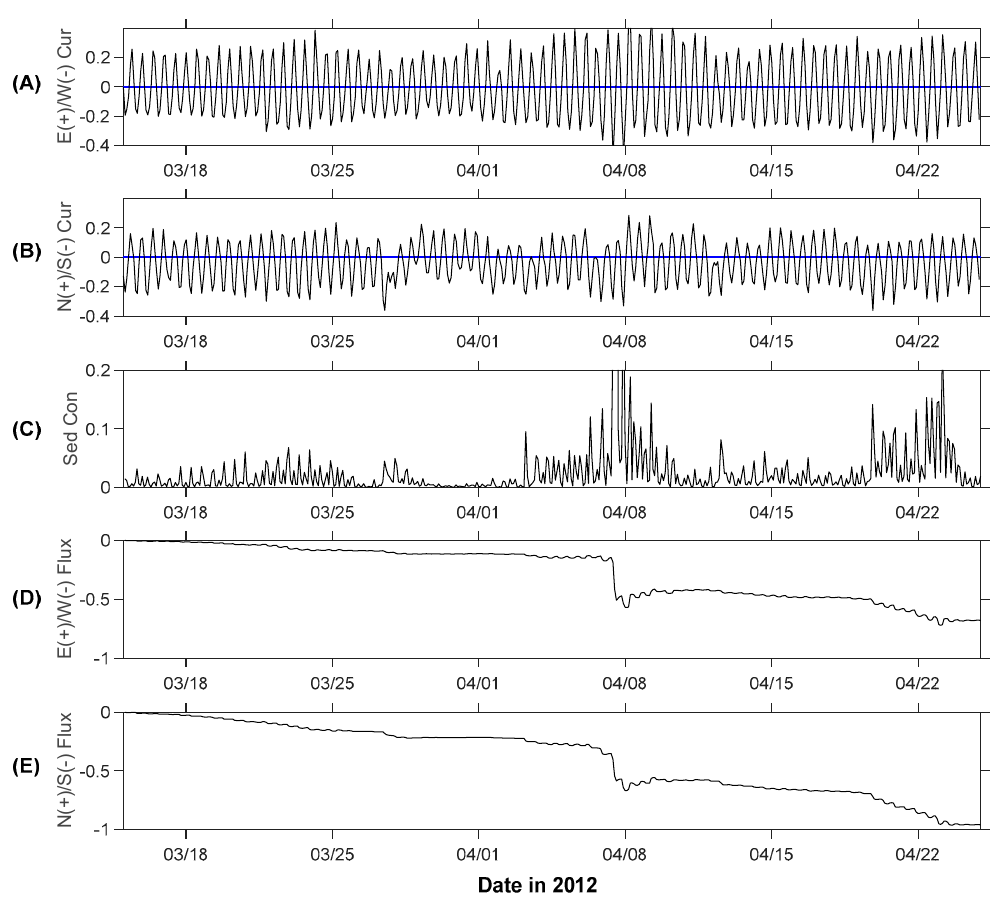
Figure 8. ( A ) East( + ) / west( − ) and ( B ) north( + ) / south( − ) currents in m s − 1 from PCADP data at 0.7 m above bed collected at R1 in spring 2012. ( C ) Sediment concentration in kg m − 3 from ABS data at 0.7 m above bed collected at R1 in spring 2012. ( D ) East( + ) / west( − ) and ( E ) north( + ) / south( − ) cumulative sediment fluxes in kg m − 2 s − 1 at R1 in spring 2012.